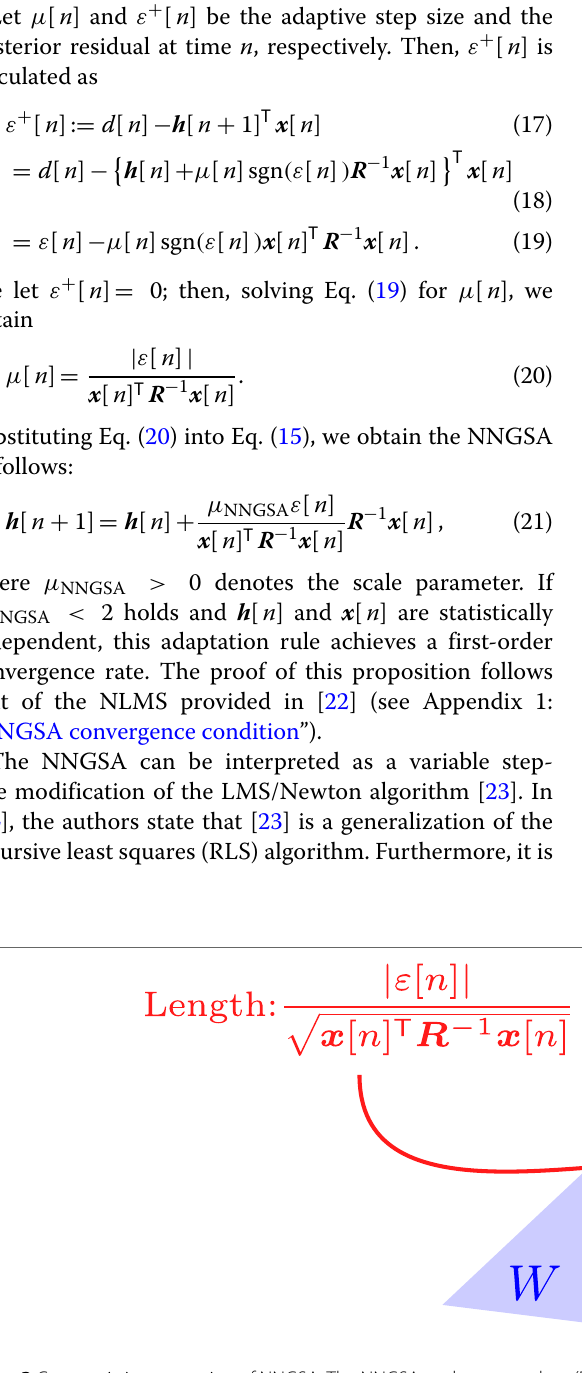
Fig. 3 Geometric interpretation of NNGSA. The NNGSA update procedure (Eq. (21)) projects h [ n ] onto hyperplane W , having the metric